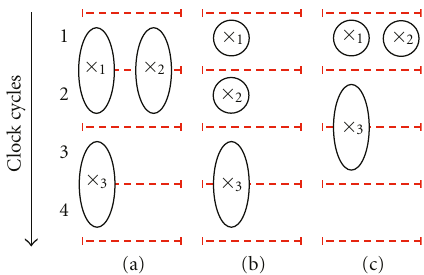
Figure 5: Time-constrained syntheses. (a) scheduling assuming operators with fixed delay, (b) Scheduling assuming operators with variable delays depending on data width, and (c) minimum latency scheduling assuming operators with variable delays depending on data